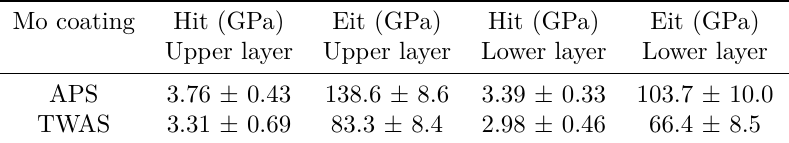
Table 1. Results of instrumented